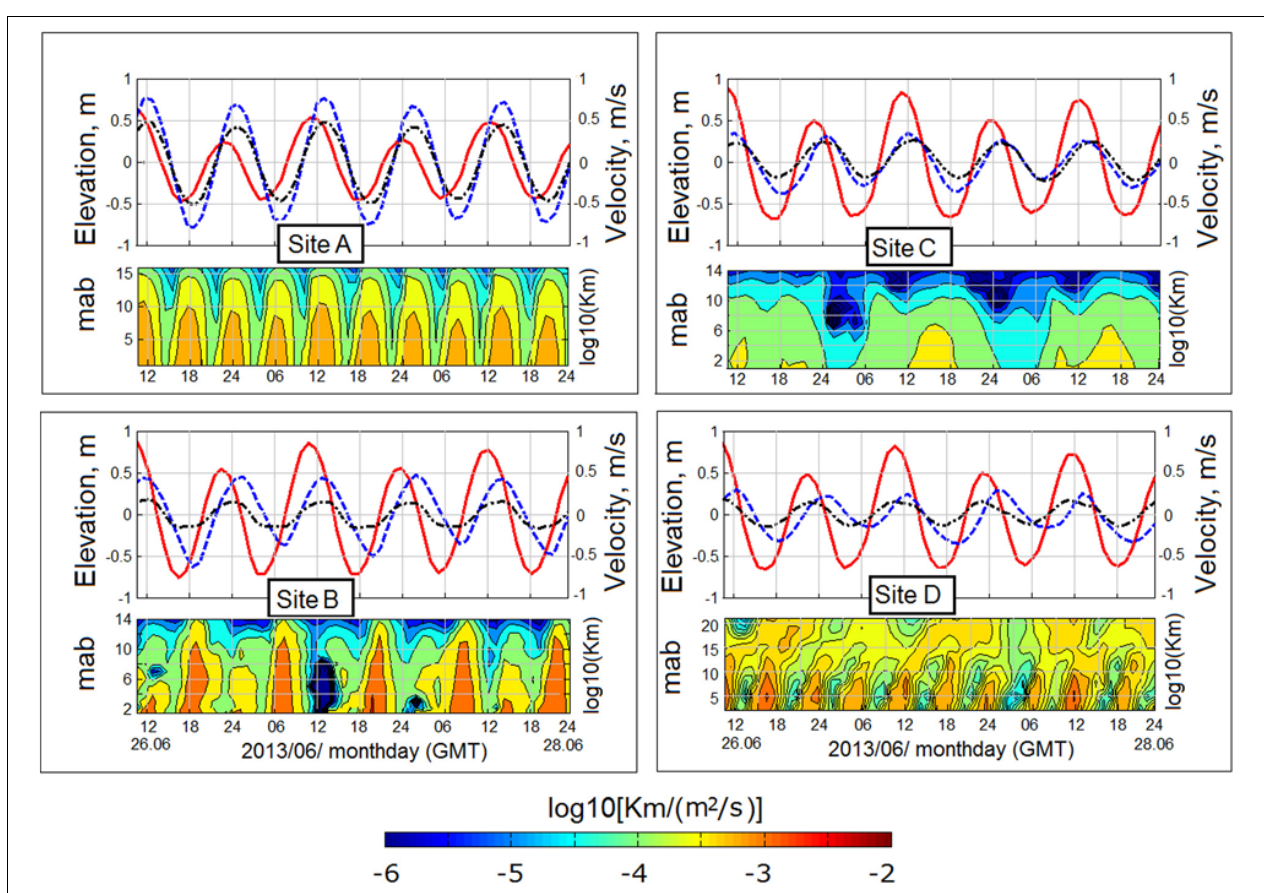
FIGURE 9 | The time-depth variability of modeled water elevation (red line), the component of meridional velocity at the surface (dash blue line) and 2 m above the bottom (dash-dot black line), and the logarithm of vertical turbulent diffusivity K m over the CYR (at Site A) and in the PCH along the meridional section MS1 at Sites B–D ( Figure 1 ). Each site (A–D) consists of two panels; the upper panel illustrates water elevation and velocity and the lower panel illustrates the distribution of turbulent diffusivity throughout the water column. Abbreviation mab denotes meters above the